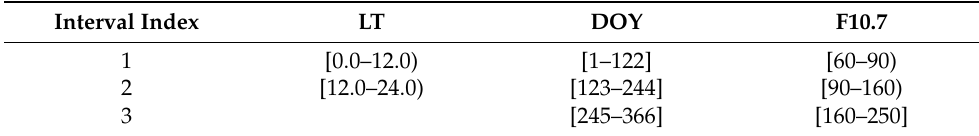
Table 1. Example interval division for the model drivers LT, DOY and